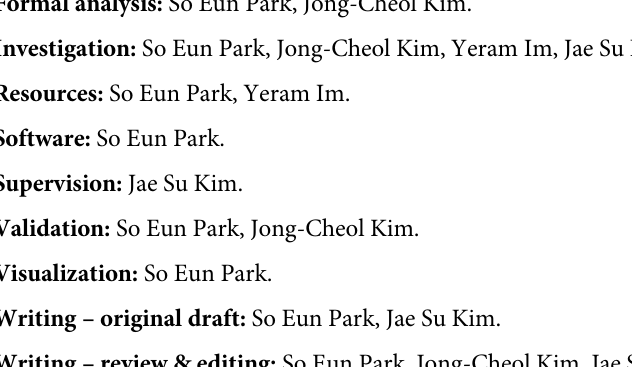
S1 Table. Primers used in qRT-PCR for validation of RNA-sequencing. S2 Table. Summary of Illumina sequences. S3 Table. De novo assembly of red mite sequences. S4 Table. KEGG pathway of infecting B . bassiana JEF-410 DEGs. S5 Table. KEGG pathway of infected red mite